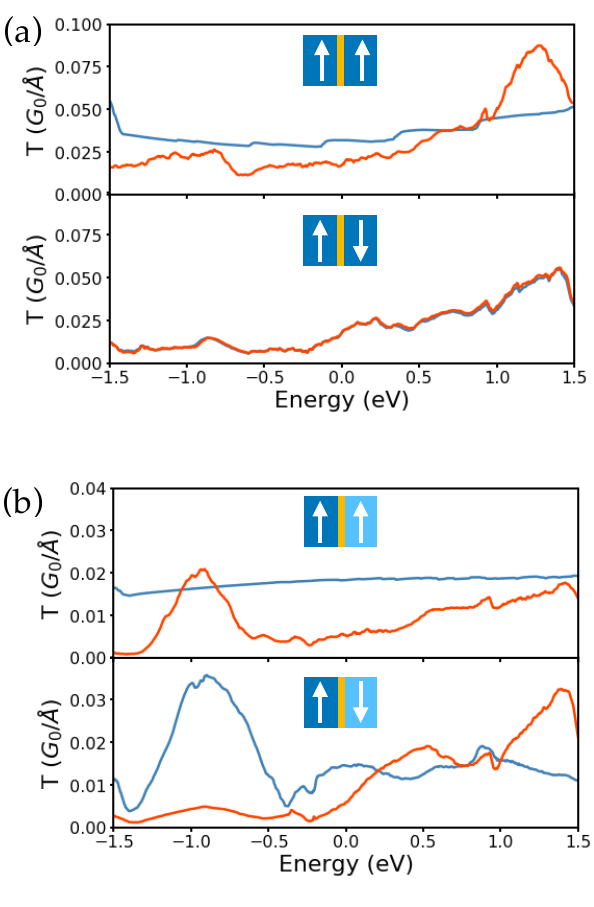
Figure 11. The spin dependent electronic transmission function of a ( a ) symmetric and ( b ) asymmetric Co 1 / h -BN/Co 2 junction with both the parallel and anti-parallel relative orientation of FM magnetization. The transmission functions of the majority and minority spins are depicted in blue and red respectively. In the symmetric junction, Co 1 , h -BN and Co 2 are exactly aligned hence giving rise to two epitaxial interfaces (see Figure 10b). In the asymmetric case, Co 1 and h -BN are aligned but Co 2 has been twisted by an angle of 21.78 ◦ hence corresponding to a less strongly bonded interface (see Figure